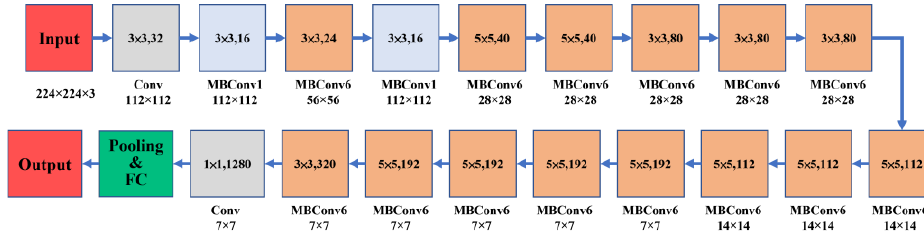
Figure 9. EfficientNetB0 architecture.